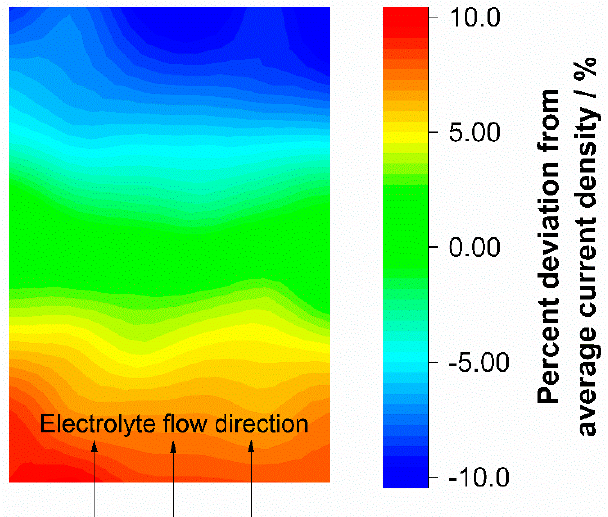
Figure 5. Current density distribution during discharge with 100 mA cm − 2 and an electrolyte flow rate of 0.5 mL min − 1 cm − 2 ( λ ≈ 6.5). Electrolyte flow was from the bottom to the top and the ohmic resistance induced current density distribution from Figure 4a was subtracted as an offset.